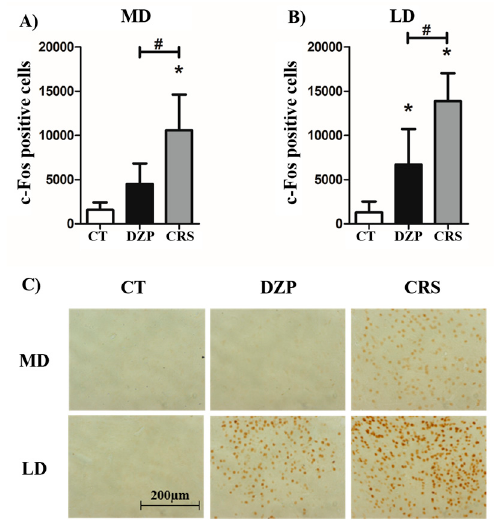
Figure 3. Mean density of c-Fos positive cells normalized to volume for ( A ) MD and ( B ) LD thalamic nuclei; ( C ) c-Fos immunostaining in MD and LD of CT, DZP and CRS rats. * p < 0.05: statistically significant difference from CT rats; # p < 0.05: statistically significant difference from DZP rats. The factorial analysis of the data generated two components and revealed a positive correlation between MD, LD, and ventrobasal (VB) thalamic nuclei, which were negatively correlated with the